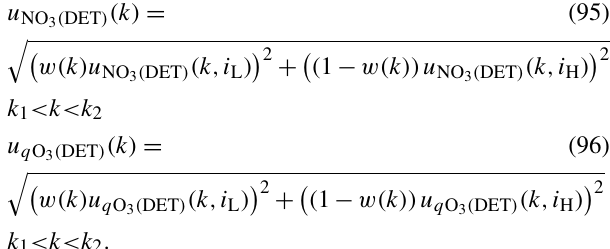
Figure 15. Same as Fig. 14, but for tropospheric ozone DIAL sys-